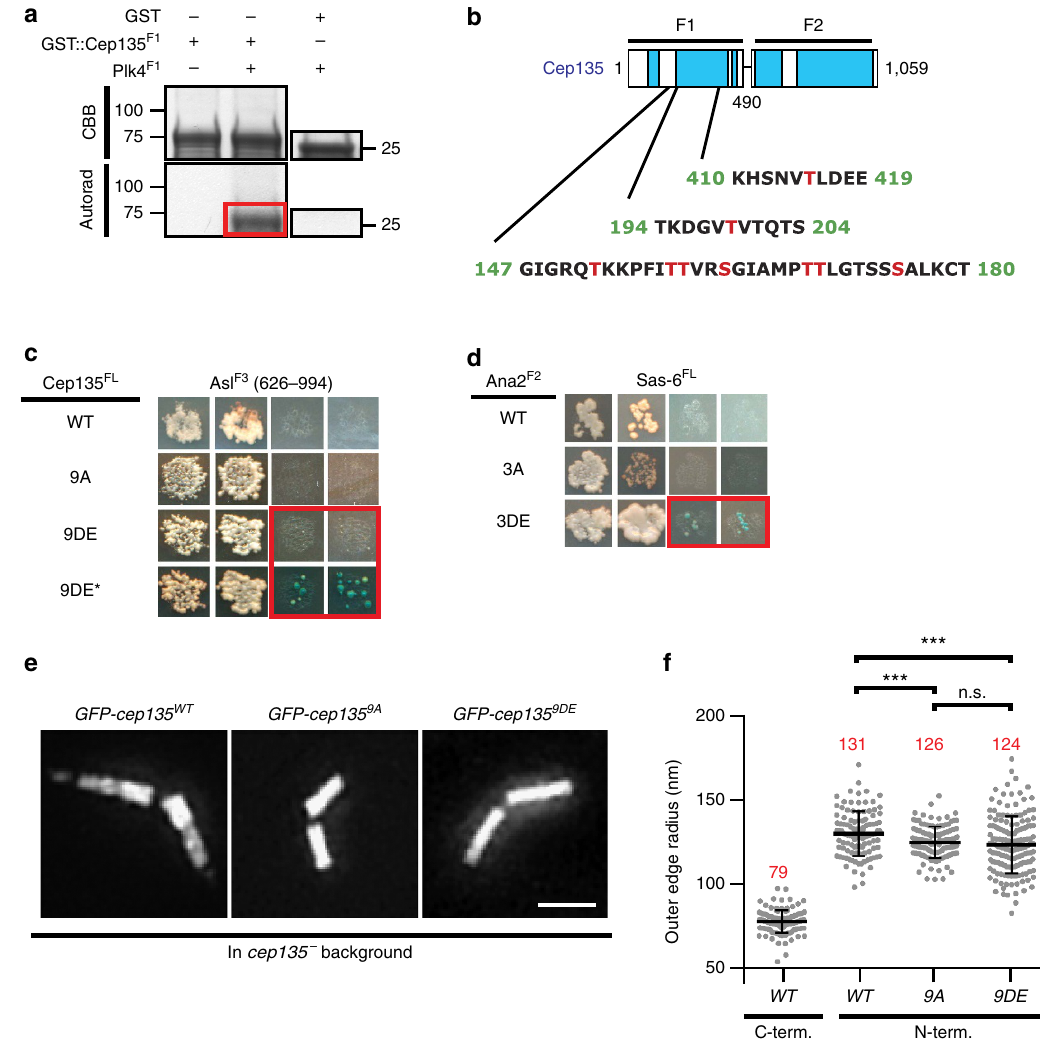
Figure 6 | Plk4 phosphorylates Cep135 and regulates its interactions. ( a ) Plk4 phosphorylates Cep135 1–490 (red box) in an in vitro kinase assay. Coomassie brilliant blue (CBB) gel (top) and autorad (bottom); GST used as negative control (right). ( b ) Schematic of Cep135 indicating the phosphorylated residues (red) identified by in vitro kinase assay with Plk4. ( c ) Phosphomimetic Cep135 FL-9DE gains interaction with Asl F3 (red box), while Cep135 FL-WT and Cep135 FL-9A do not. Images are representative of four independent experiments. Asterisk indicates 10-day growth. ( d ) Phosphomimetic (3DE) Ana2 F2 interacts with Sas-6 FL (blue box), but wild type (WT) and unphosphorylatable (3A) Ana2 F2 do not. Y2H data are arranged as in Supplementary Fig. 1c. ( e ) Images of spermatocyte centrioles from transgenic animals expressing the indicated constructs in the cep135 mutant background. GFP-tagged WT, unphosphorylatable (9A) and phosphomimetic (9DE) Cep135 localize to centrioles in the spermatocytes of transgenic flies. ( f ) Outer edge radii of Cep135 on spermatocyte centrioles. Bars indicate the mean (red numbers) ± s.d. Numbers of centrioles measured—WT C-term N ¼ 117 (same data as in Fig. 3d), WT N-term N ¼ 109 (same data as in Fig. 3d), 9AN ¼ 124, 9DE N ¼ 154. Comparisons made by unpaired t -tests, with Welch’s corrections when appropriate. *** P r 0.001, n.s., not significant. Scale bars, 1 m